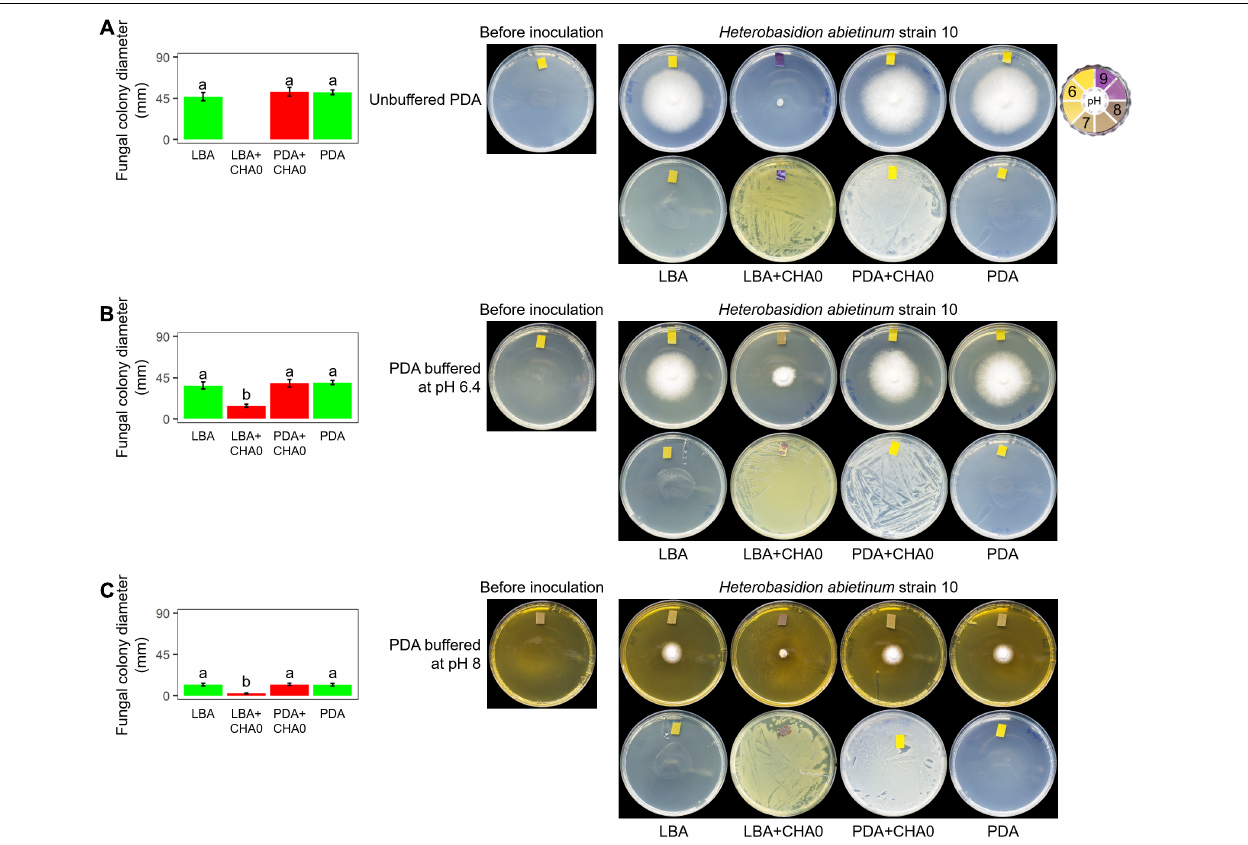
FIGURE 5 | Experiment F . Alkalization of potato dextrose agar (PDA), unbuffered (A) or buffered at pH 6.4 (B) or 8 (C) , mediated by the volatiles of Pseudomonas protegens CHA0, and effect on the growth of Heterobasidion abietinum strain 10. Halos around the fungal colonies were due to diffusible substances secreted by the fungus and did not contain hyphae. In the graphs, error bars are the standard error of the mean of three replicates (plates). Within each graph, bars with different letters are significantly different according to the LSD test ( P < 0.05).